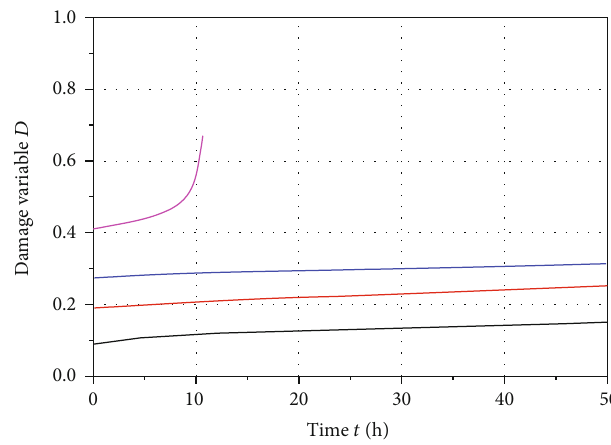
Figure 9: Variation of damage parameter D with